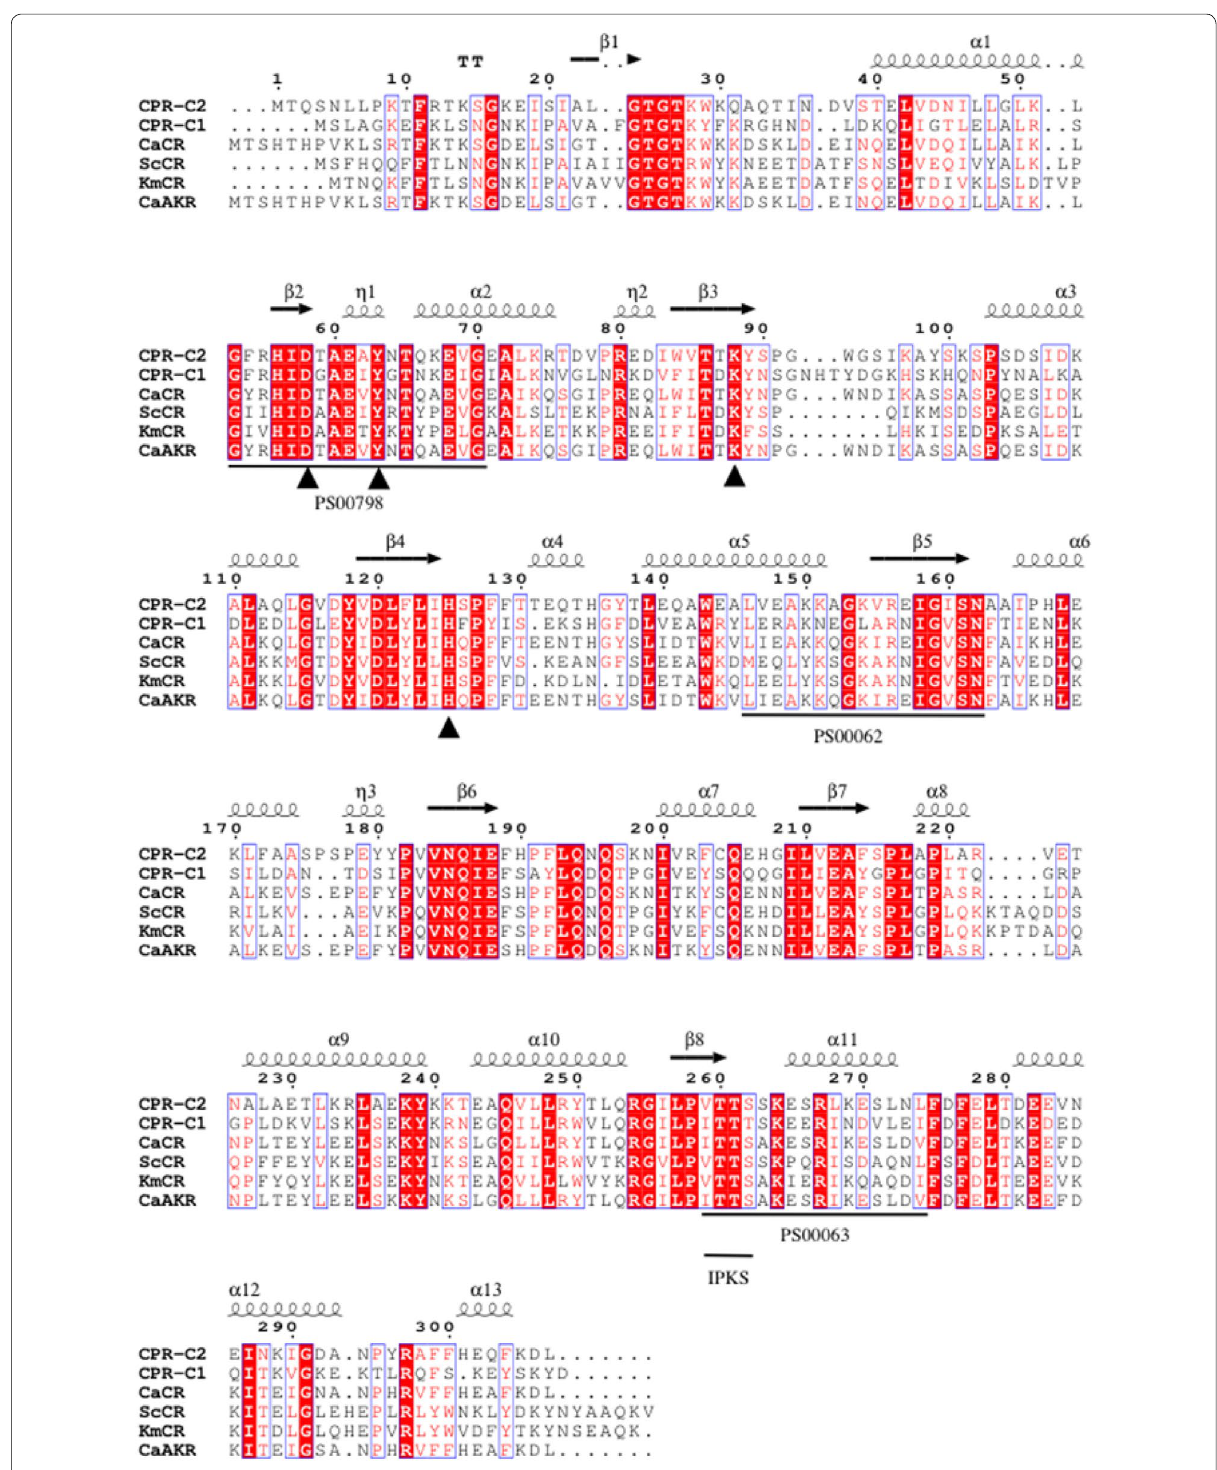
Fig. 1 Amino acid sequence alignment of the selected proteins and CaAKR. Identical amino acid residues are shown in enclosed boxes. The conserved catalytic tetrad is labeled with triangles, and the AKR family signature sequences are